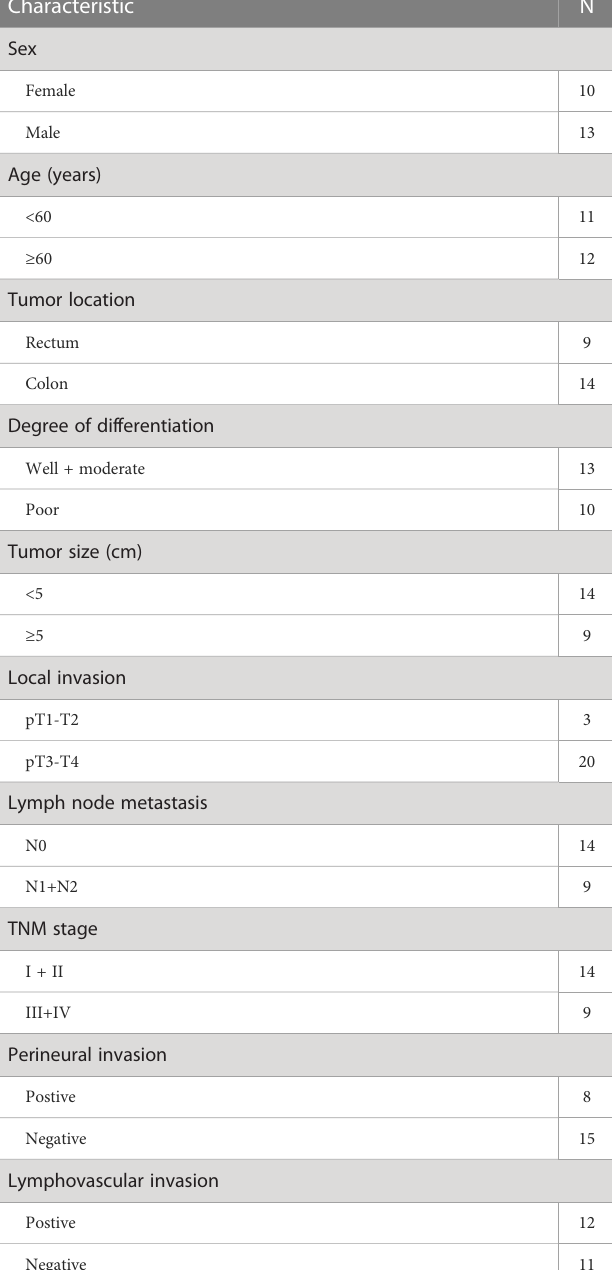
TABLE 2 Clinicopathological characteristics of the second study cohort (n=23) for assessing USP20 mRNA level.